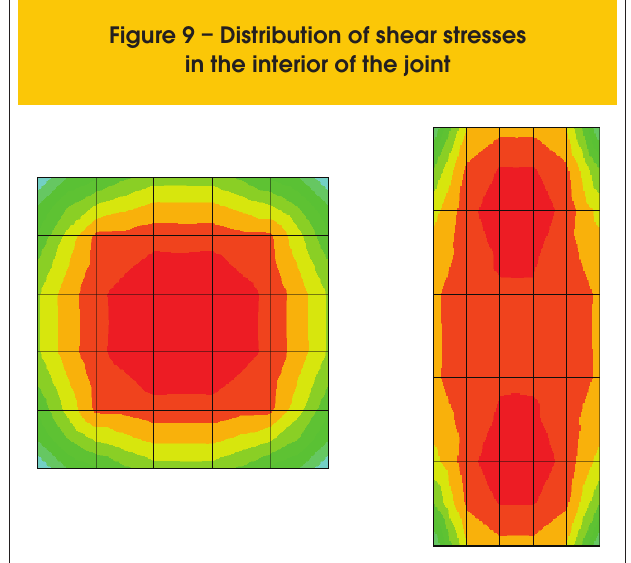
Figure 9 – Distribution of shear stresses in the interior of the